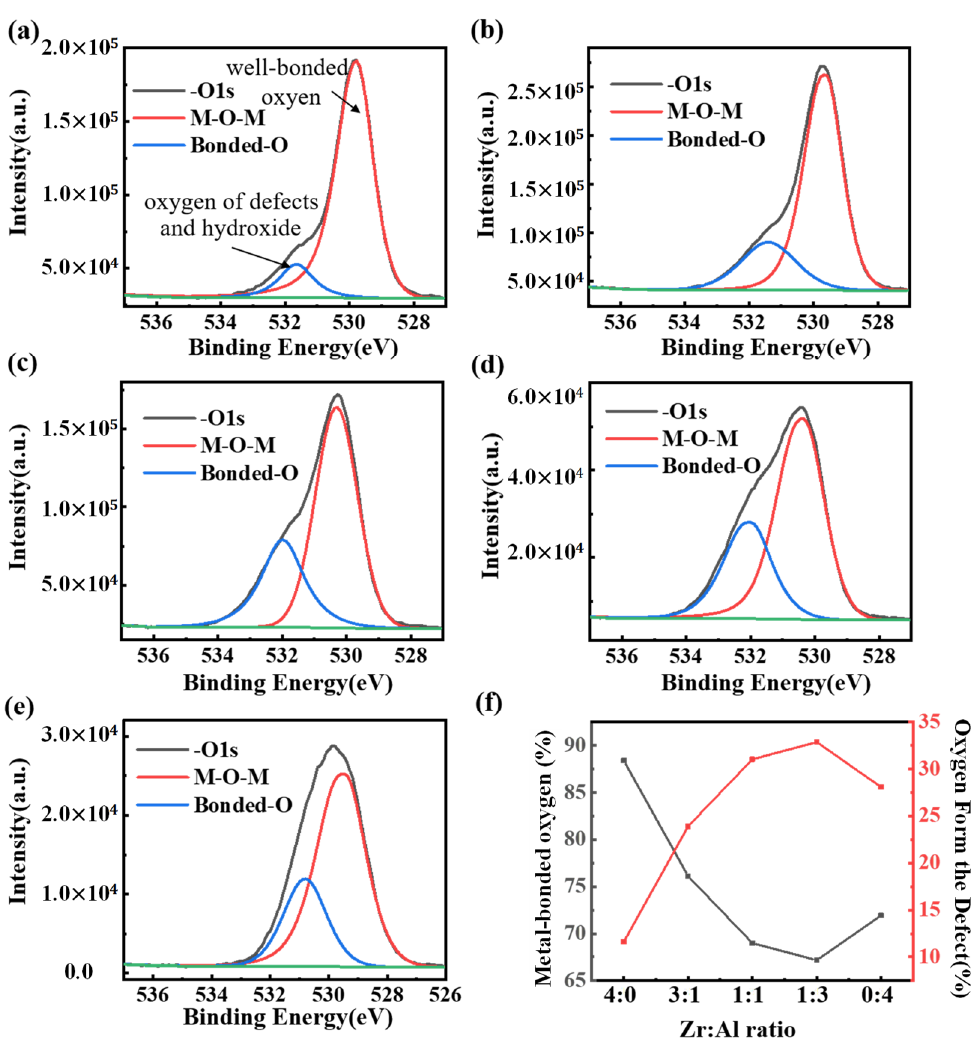
Figure 5. XPS spectra: ( a – e ) O 1s for different films (with molar ratios of Zr:Al = 4:0, 3:1, 1:1, 1:3 and 0:4) annealed at 400 °C; and ( f ) the tendency of oxygens as a function of the ratios.